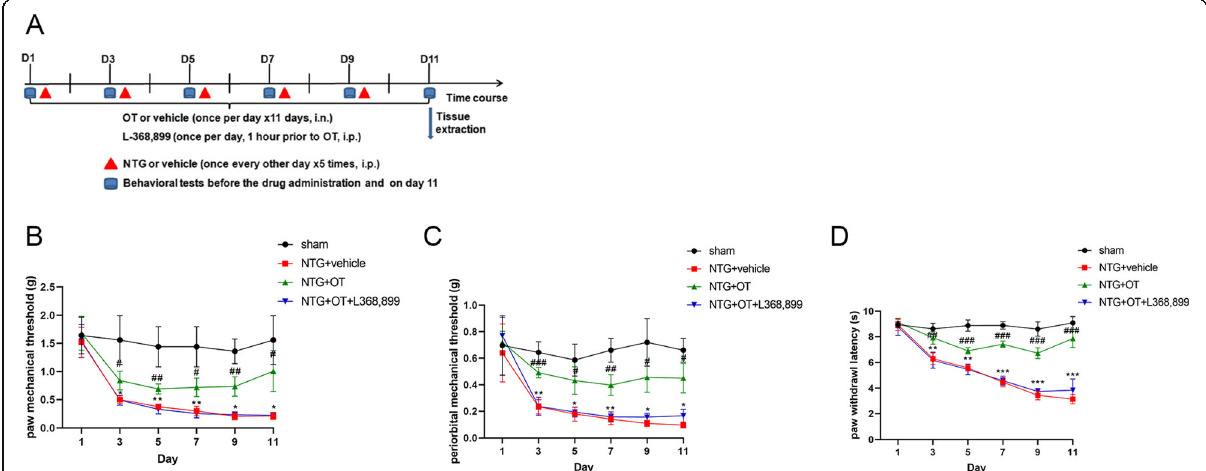
Fig. 3 OT ameliorated pain sensitization and reduced neuronal activation via OTR. A Timeline for the second experiment. Note that L-368,899 was intraperitoneally injected daily 1 h before OT treatment. The mechanical and thermal pain thresholds of the hind paw and periorbital area were assessed before each NTG injection and on day 11. B , C , D The basal mechanical pain thresholds of the hind paw ( B ), periorbital area ( C ), and the thermal pain response of the hind paw ( D ) were significantly increased in the NTG + OT group compared with the NTG + vehicle group. The pain threshold in the NTG + OT + L368,899 group was markedly decreased compared with the NTG + OT group. Moreover, there was no significant difference between the NTG + vehicle and NTG + OT + L368,899 groups. Two-way ANOVA with the Bonferroni post hoc test, n = 6/ group; # p < 0.05, ## p < 0.01, ### p < 0.001 vs. the NTG + vehicle; * p < 0.05, ** p < 0.01, *** p < 0.001 vs. the sham